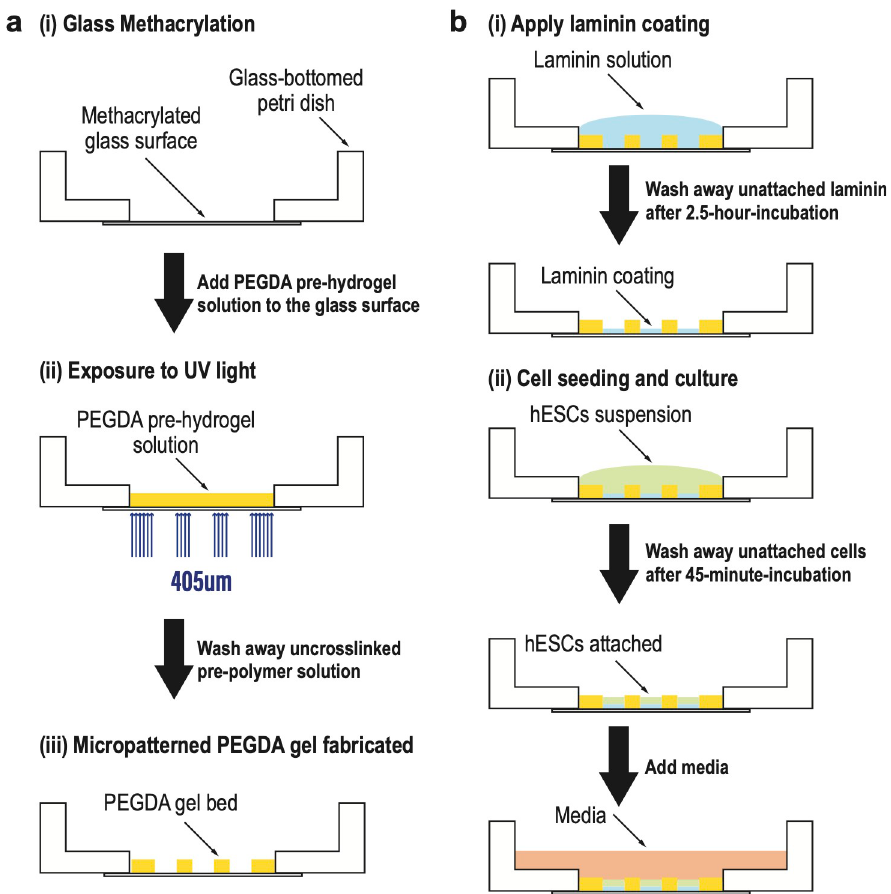
Fig 1. The methodology for PEGDA-based micropatterning on methacrylated glass-bottomed petri dish by photo crosslinking. ( a ) Schematic illustration of the fabrication process (i) Glass surface methacrylation; (ii) PEGDA pre- hydrogel solution was added onto the glass surface, and then exposed to UV light (wavelength = 405 μ m) with the virtual photomask embedded; (iii) Micropatterned PEGDA gel was fabricated on the glass surface. Uncrosslinked pre- hydrogel solution was removed by multiple PBS washes. ( b ) Schematic illustration of hESC seeding and culture (i) Laminin coating was applied on the micropatterned surface. Unattached laminin was washed away after 2.5-hr- incubation at 37˚C; (ii) hESC suspension was added at desired density on the laminin coated surface. Unattached cells were washed away after 45-min-incubation at 37˚C. Following seeding, media with desired reagents was added to the dish for further culture or